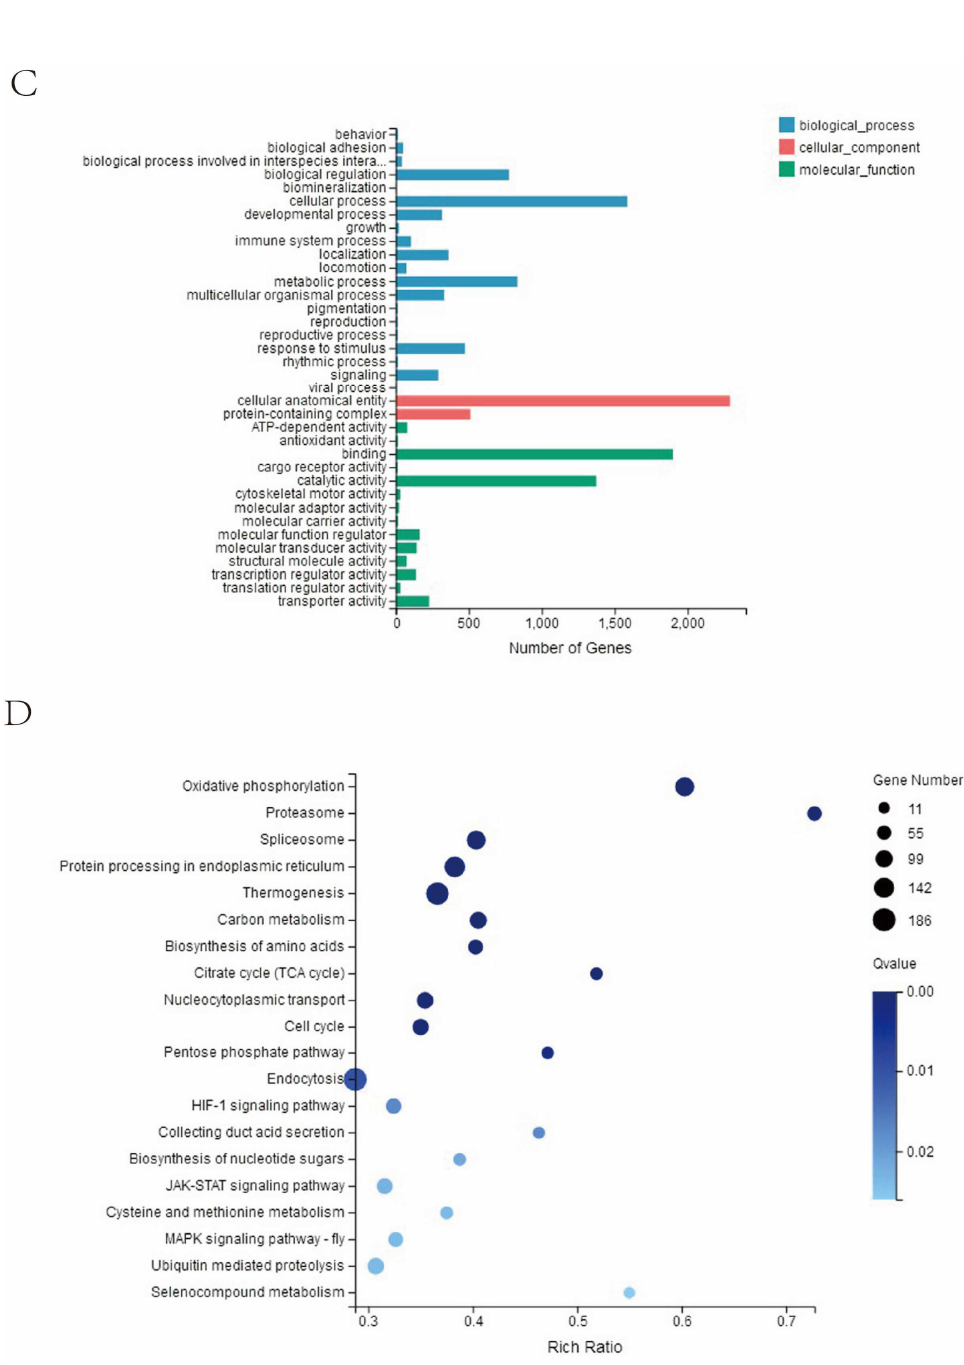
Figure 6. Differential gene expression, clustering, and functional enrichment analysis. ( A ) Volcano plot analysis of differentially expressed unigenes (DEGs). The horizontal ordinate represents the fold change in gene expression in the different experimental groups and the vertical ordinate represents the statistical significance of the change in gene expression. Red plots represent a significant enrichment of DEGs ( p < 0.05). Green plots represent significant downregulation of DEGs ( p < 0.05). ( B ) Hierarchical clustering analysis of total genes between the control and infectious spleen and kidney necrosis virus (ISKNV)-ZY-infected groups (fold change > 2, p < 0.05). The color in the heat map represents gene expression changes. ( C ) Gene Ontology (GO) terms in biological process, cellular component, and molecular function categories with enriched DEGs. ( D ) Top 20 enriched pathways for the total genes on Kyoto Encyclopedia of Genes and Genomes (KEGG)